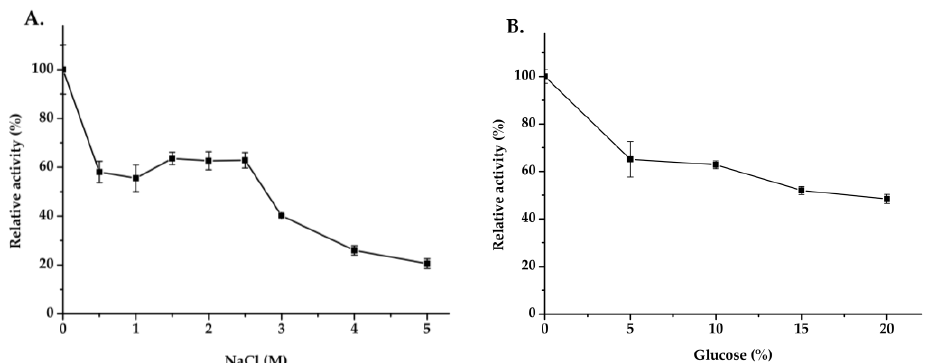
Figure 7. Effect of NaCl ( A ) and gluose ( B ) of Mg9373 on active and stability. ( A ) Effect of NaCl on stability. The stability of Mg9373 was determined at 40 °C in McIlvaine buffer (pH 6.0) after incuba- tion at various NaCl (0 – 5 M). ( B ) Effect of glucose stability. The stability of Mg9373 was determined after incubation at various glucose (0 – 20%), at 40 °C in McIlvaine buffer (pH 6.0). Table 3. Effect of 10 mM and 20 mM metal ions and chemical reagents on the MG9373 activity.